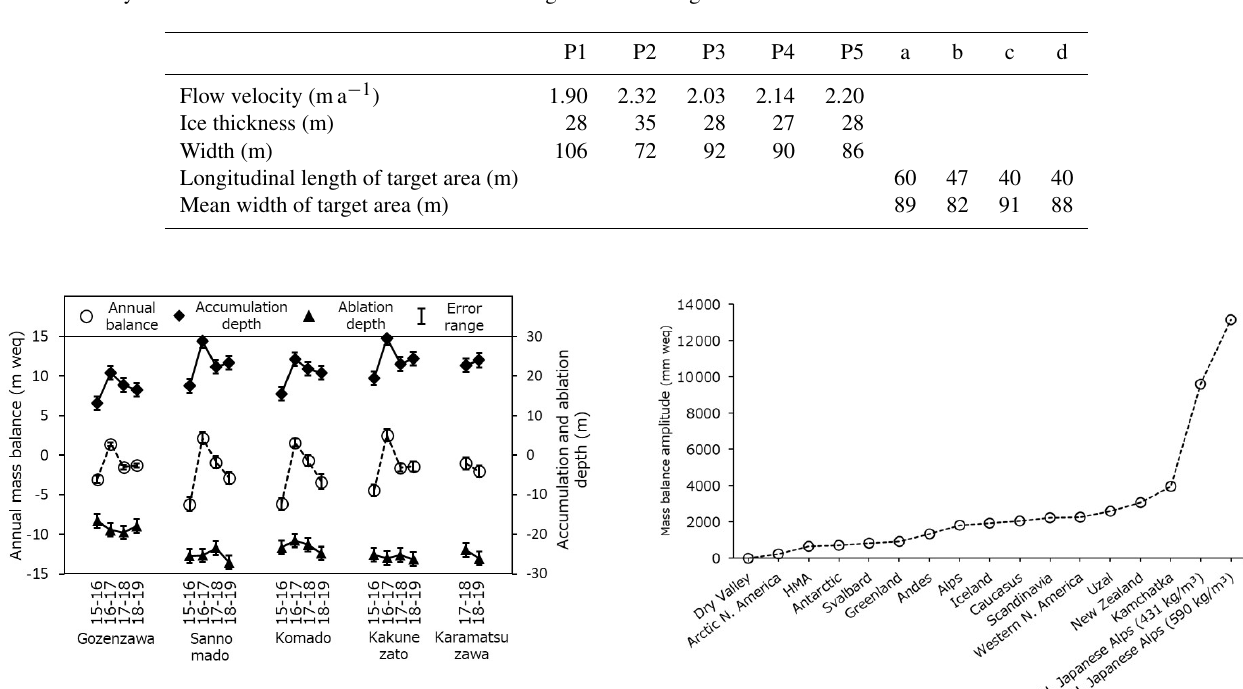
Table 5. Analyses results for the Karamatsuzawa Glacier. Regions refer to Fig. 6.